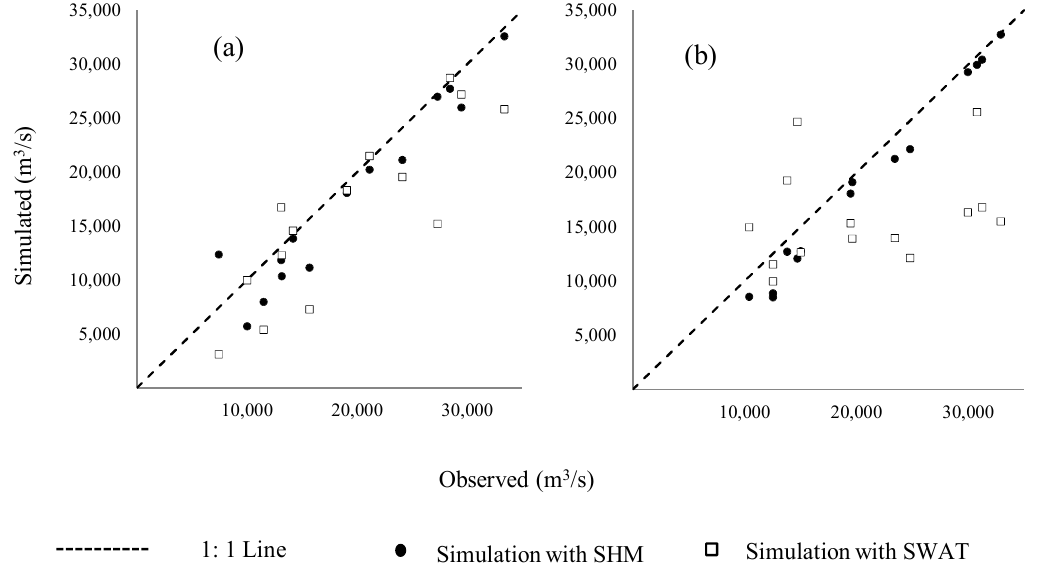
Figure 3. Comparison between observed and models simulated annual peaks during ( a ) calibration and ( b ) validation